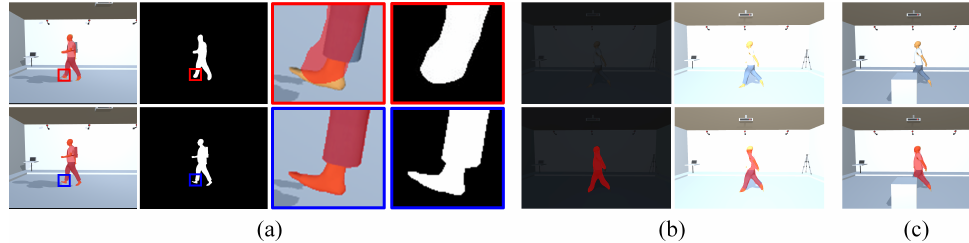
Figure 9. Performance of mask extraction: columns 1–4 ( a ) show the comparison between mask- RCNN [49] and our system; columns 5–6 ( b ) show the extraction quality of mask-RCNN under various lighting conditions; column 7 ( c ) shows mask extraction of mask-RCNN with occlusion.